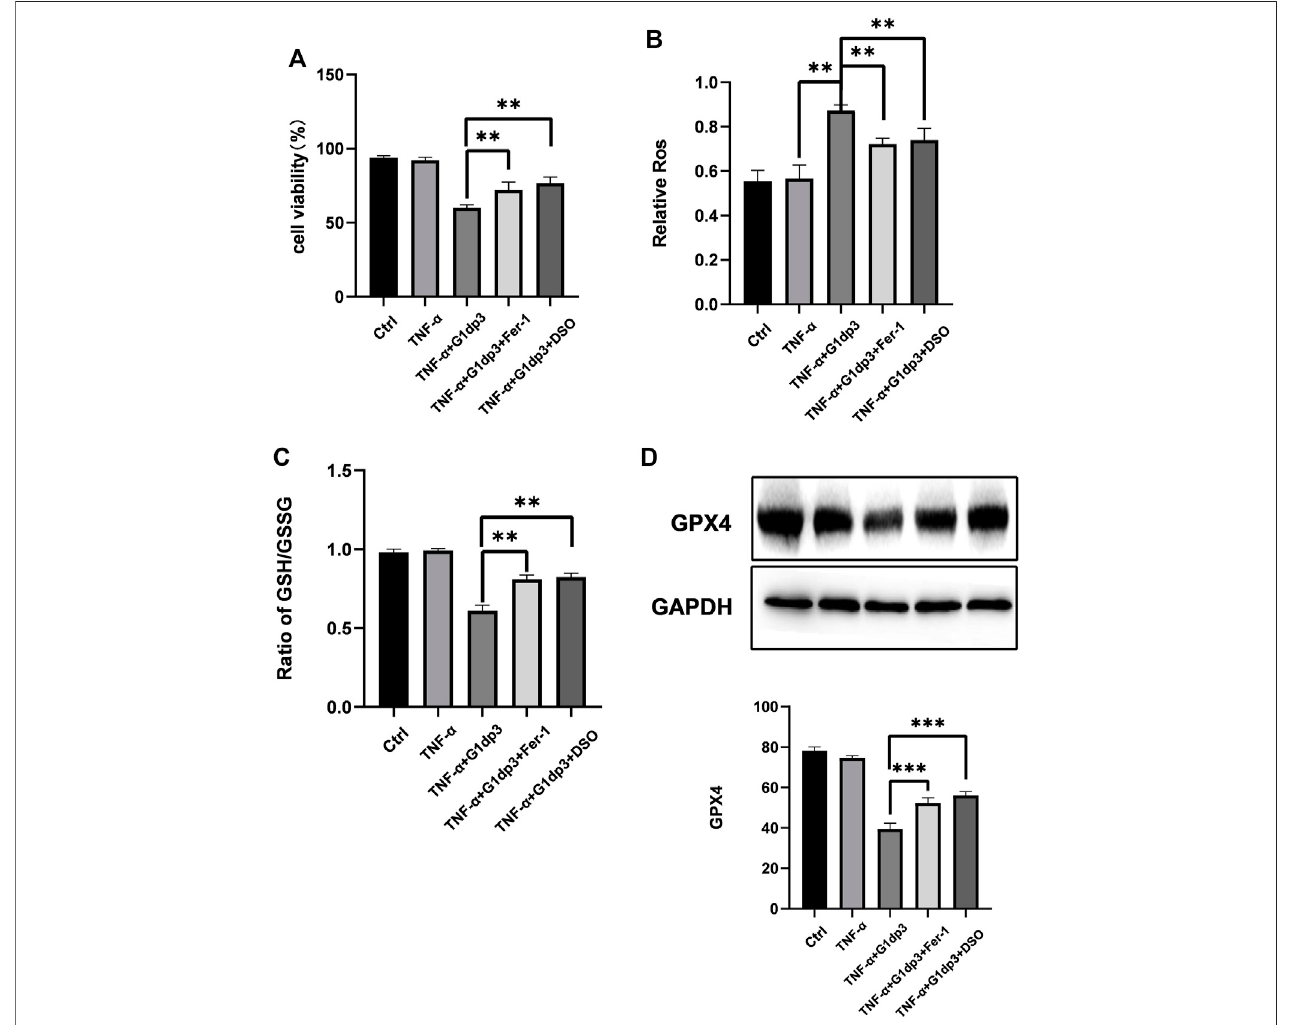
FIGURE 3 | Inhibition of ferroptosis alleviates G1dP3-induced suppression of MH7A cell viability MH7A cells were pretreated with the ferroptosis-speci fi c inhibitor Fer-1 (2 μ M), iron chelator DFO (80 μ M) for 24 h, and then coincubated with G1dP3. (A) Cell viability was detected in the indicated MH7A cells. (B) Relative lipid peroxidation levels in the indicated MH7A cells. (C) Ratio of GSH/GSSG in the indicated MH7A cells. (D) Protein levels of Gpx4 in the indicated treatment. Graph represents mean ± SD; * p < 0.05, ** p < 0.01, *** p < 0.001, ns, not signi fi cant. Representative data from one of three individual